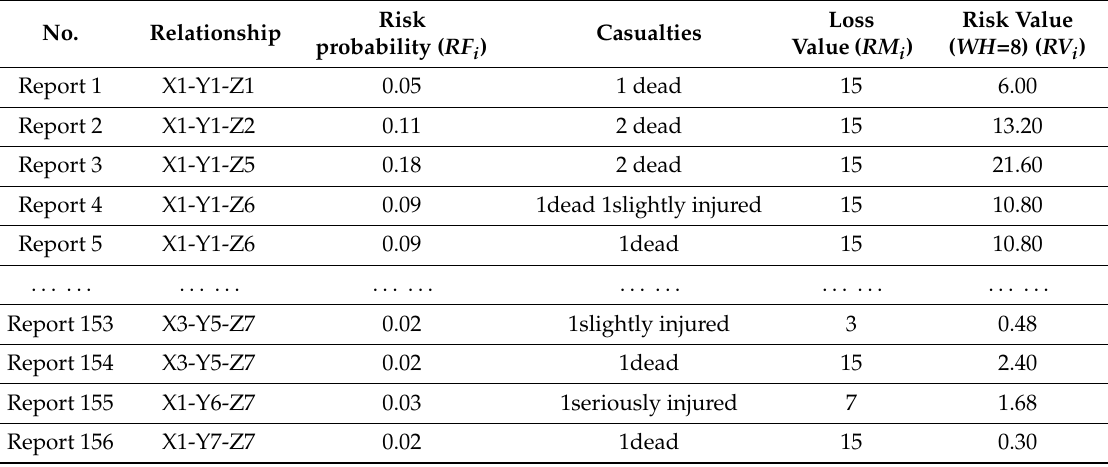
Table5. Safety risk factor relationships and risk values. Table 5. Safety risk factor relationships and risk